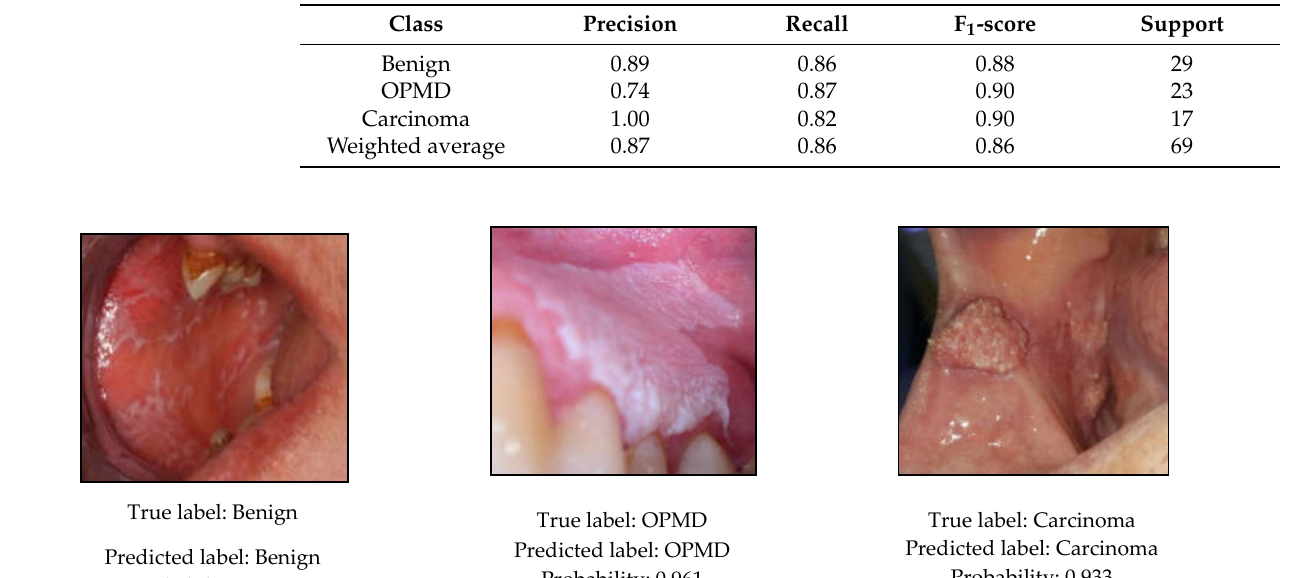
Figure 6. Predicted class labels and probabilities for the test images by the EfficientNet-b4 classification model.